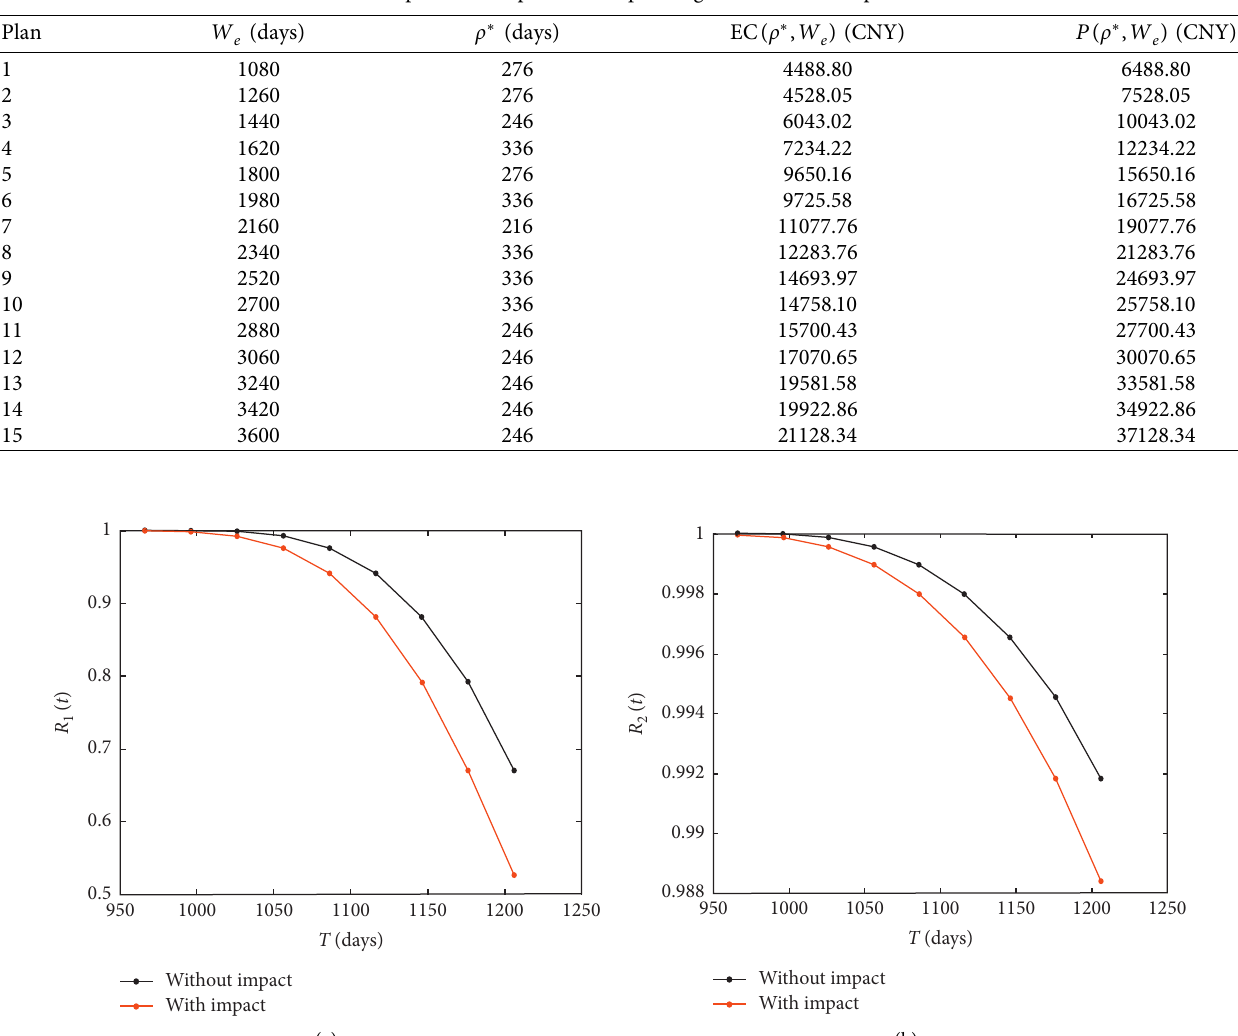
Table 3: Optimization plans corresponding to different EW periods.